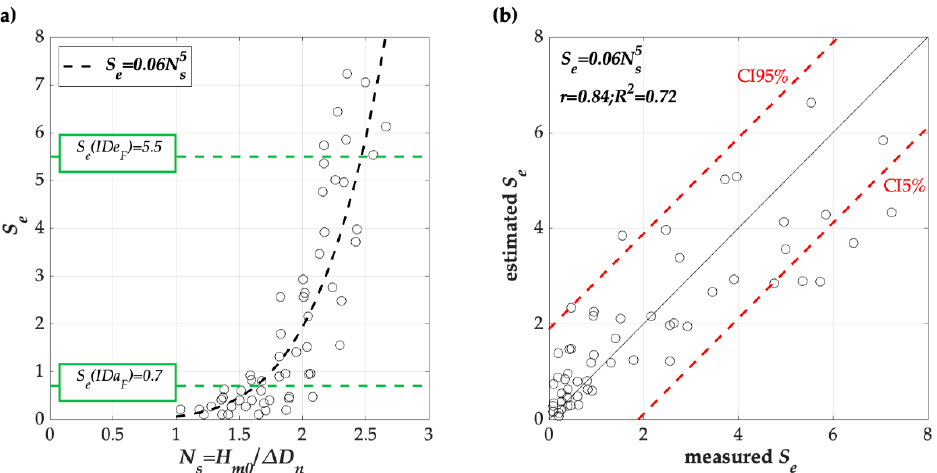
Figure 7. Performance of Equation (14) with K 1 = 0.06 and K 2 = 5 to estimate armor damage of the front slope of the rock-armored model: ( a ) Fitting to the measured data, IDa and IDe levels, and ( b ) measured against estimated S e .